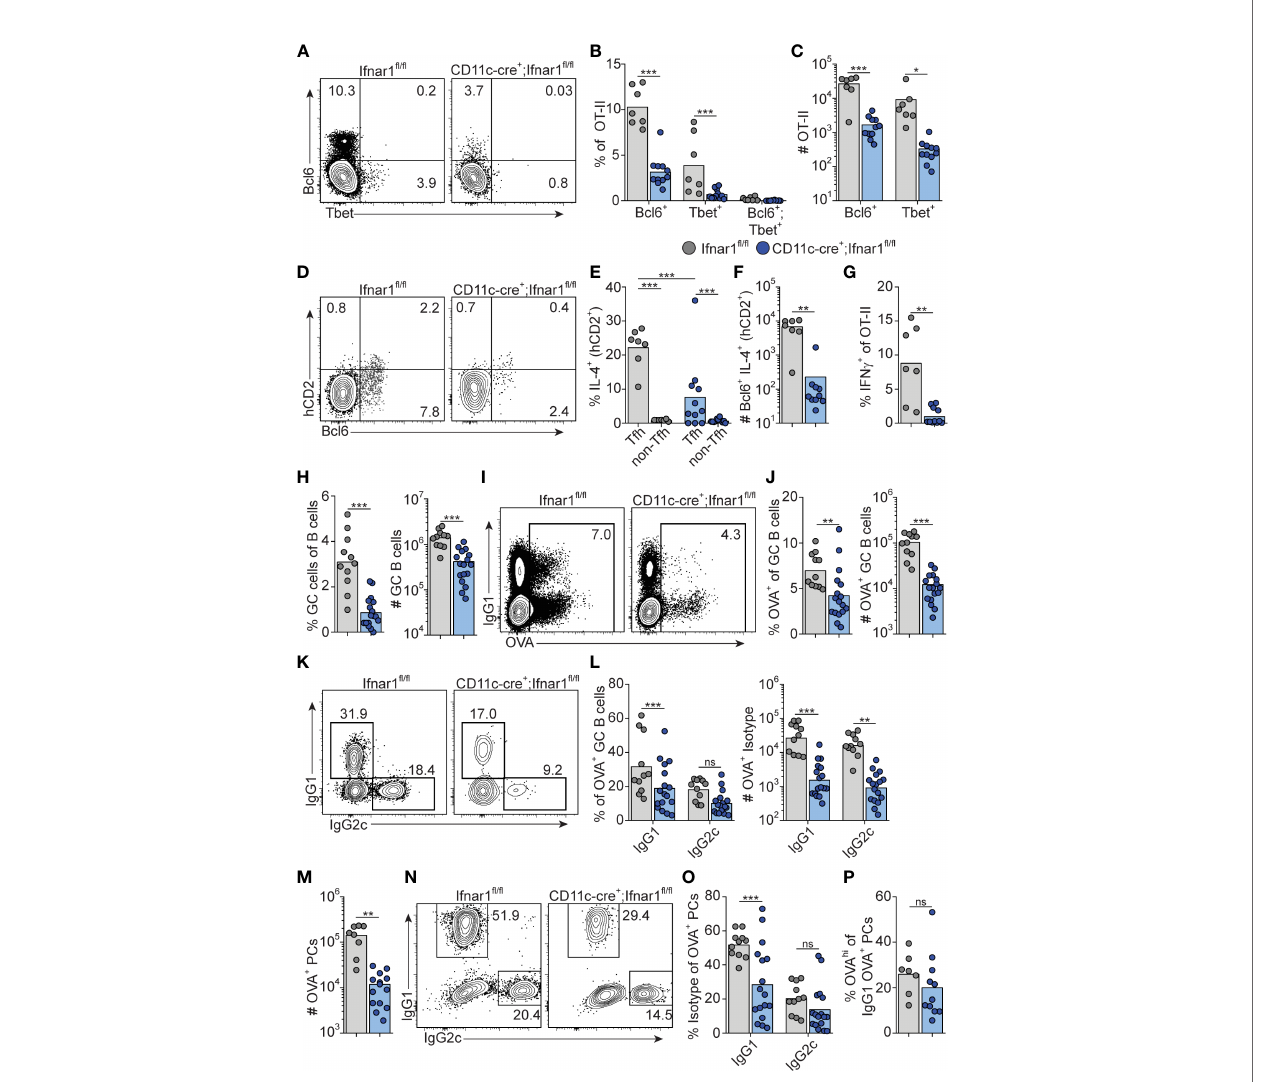
FIGURE 8 | Type I IFN signaling in cDC regulates Th1, Tfh and GC B cell development. Ifnar1 fl / fl and CD11c-cre;Ifnar1 fl / fl mice were transferred with 50 000 KN2- OT-II cells, immunized with OVA/poly I:C and splenocytes were analyzed by fl ow cytometry 8 dpi. (A – G) Analysis of donor KN2-OT-II cells gated as B220 - CD4 + TCRV b 5.1 + TCRV a 2 + CD44 + cells. (A – C) T-bet versus Bcl6 expression with representative contour plots (A) and pooled results of frequency (B) and number (C) of Bcl6 + and T-bet + KN2-OT-II cells. (D – F) IL-4 secretion reported by hCD2 expression by Tfh (Bcl6 + ) donor cells. (D) Representative contour plots of Bcl6 versus hCD2 expression. (E) Percentage of IL-4 secreting Tfh and non-Tfh cells. (F) Number of IL-4 secreting Tfh cells. (G) Frequency of IFN- g + cells of total KN2-OT-II cells. (H) Percentages and number of GC B cells (B220 + CD95 + CD38 - ). (I – L) Analysis of OVA-Alexa647 binding GC B cells. (I, J) Representative contour plots of OVA-binding versus IgG1 expression (I) and pooled results of percentages and number of OVA + GC B cells (J) . (K, L) Analysis of IgG subclass distribution by OVA + GC B cells with representative contour plots of IgG2c versus IgG1 expression (K) and pooled results of percentages and numbers of IgG1 + and IgG2c + OVA + GC B cells (L) . (M – P) Analysis of OVA-Alexa647 binding PCs (B220 low CD138 + ). (M) Number of OVA + PCs. (N, O) Analysis of IgG subclass distribution by OVA + PCs with representative contour plots of IgG2c versus IgG1 expression (N) and pooled results of percentages of IgG1 + and IgG2c + OVA + PCs (O) . (P) Frequency of OVA hi cells among OVA + IgG1 + PCs. Results are pooled from three independent experiments. Each symbol represents one mouse. *p ≤ 0.05, **p<0.01 and